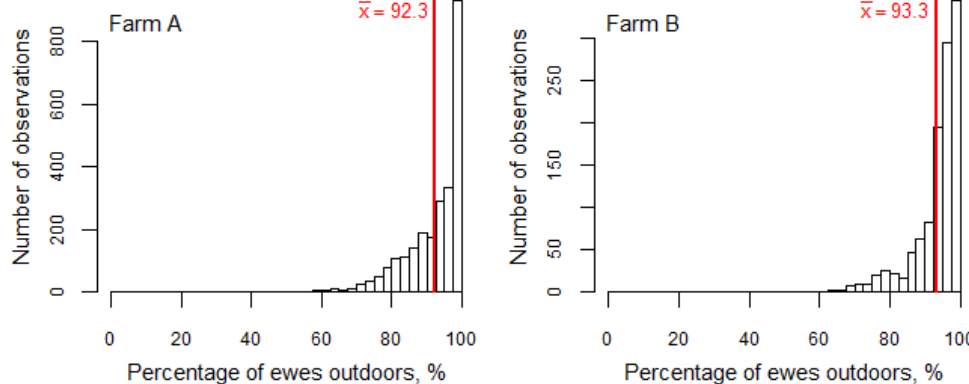
Figure 1. Percentage of ewes outdoors over the whole study period, red line and numerical value indicate the mean percentage.